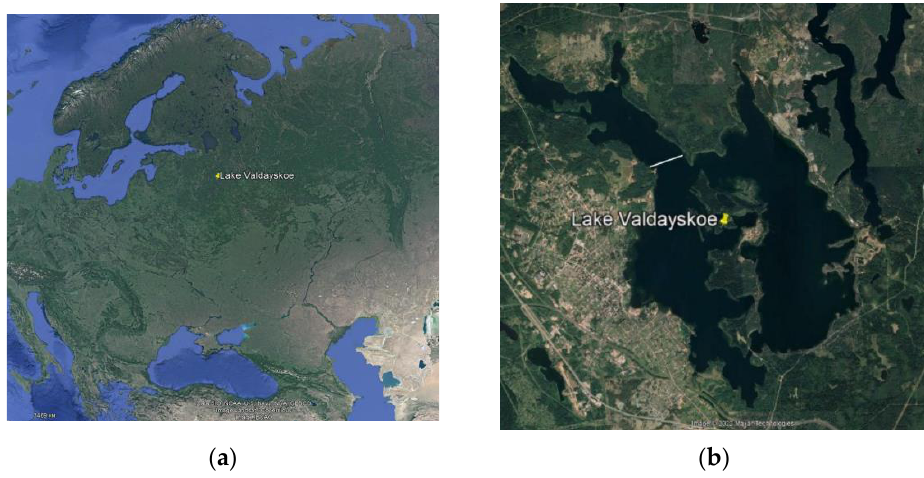
Figure 1. Map of the study region ( a ) with the location of the Lake Valdayskoe and the study site ( b ) with the location of the transect shown by a white line (https://www.google.ru/maps, accessed on 1 October